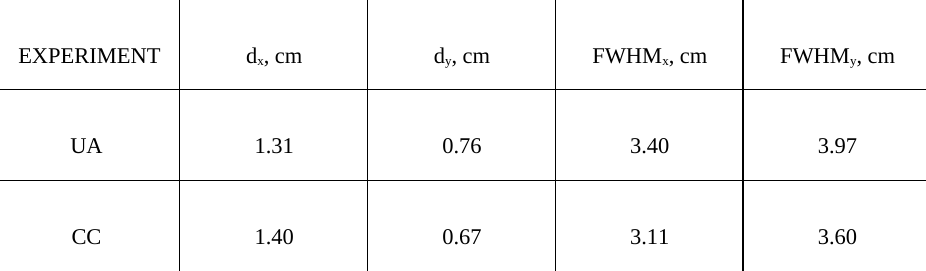
EXPERIMENT d x , cm d y , cm FWHM x , cm FWHM y , cm